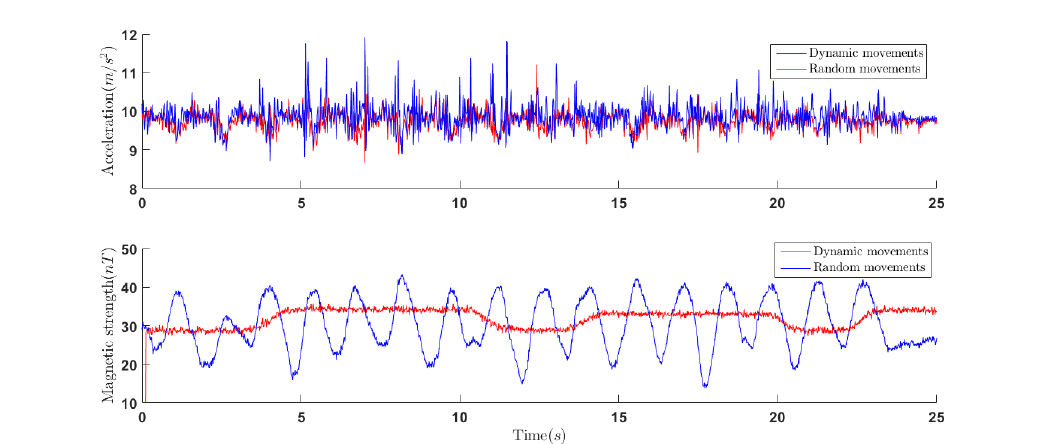
Figure 5. Norms of acceleration and magnetic field